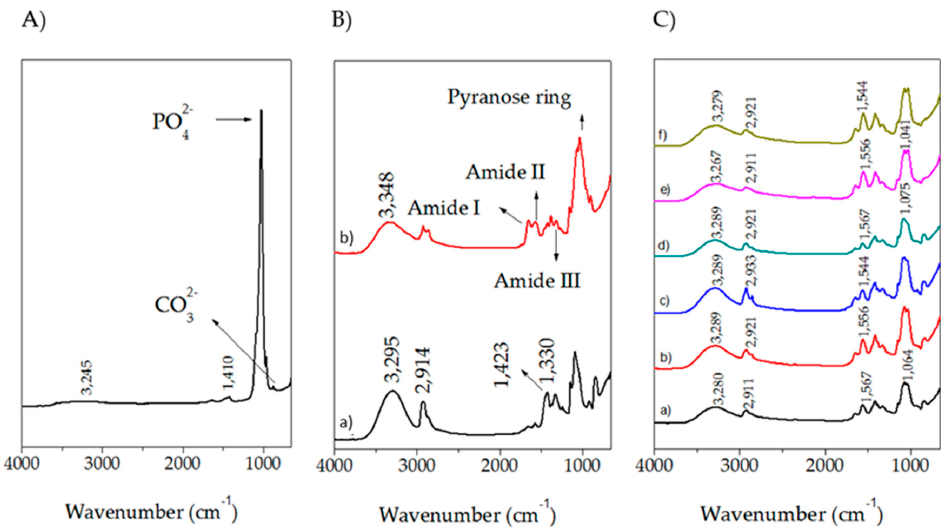
Figure 2. Collection of the obtained FTIR spectra. ( A ) Hydroxyapatite; ( B ) (a) PVA and (b) CH; ( C ) Prepared scaffolds (a) CH:PVA 1:1 GLU-GLY; (b) CH:PVA 1:1; (c) CH:PVA 1:3 GLU-GLY; (d) CH:PVA 1:3; (e) CH:PVA 3:1 GLU-GLY; (f) CH:PVA 3:1.